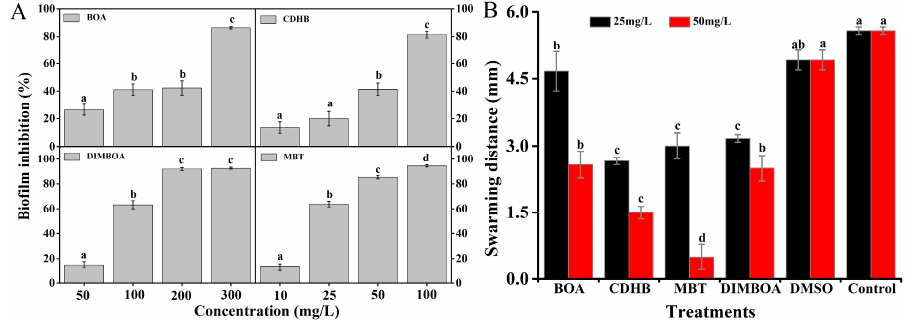
Figure 4. Effects of DIMBOA and its derivatives on biofilm formation ( A ) and swarming motility( B ) of R. solanacearum after 24 h.( A ) Biofilm inhibition (%) was quantified after treatment with different concentrations of DIMBOA and its derivatives at 30 ± 1 °C for 24 h in the 96-well plates; ( B ) The swarming diameter was measured in both the vertical and horizontal direction on each plate after incubation at 30 ± 1 °C for 24 h. The mean value in both directions was calculated. The diameter represents the average of triplicate plates. The assays were independently repeated three times. The error bars indicate the standard error of the mean from three replicates. Lower case letters indicate significant differences according to Duncan’s test ( p < 0.05).